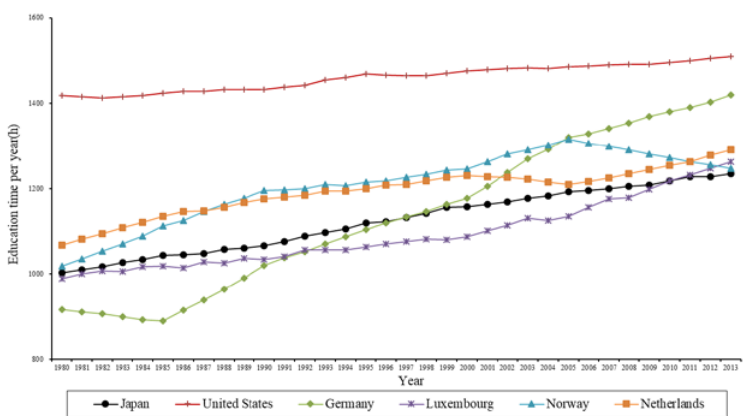
Figure 3: Comparison of education time in six countries